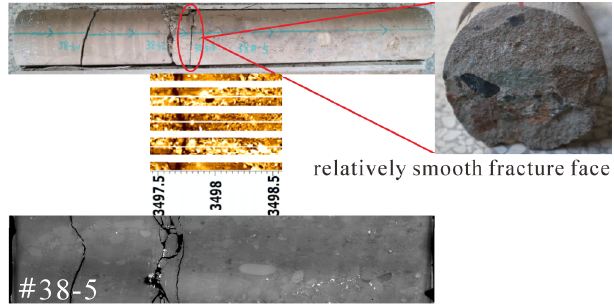
Figure 5. Features of a tensile-shear fracture.